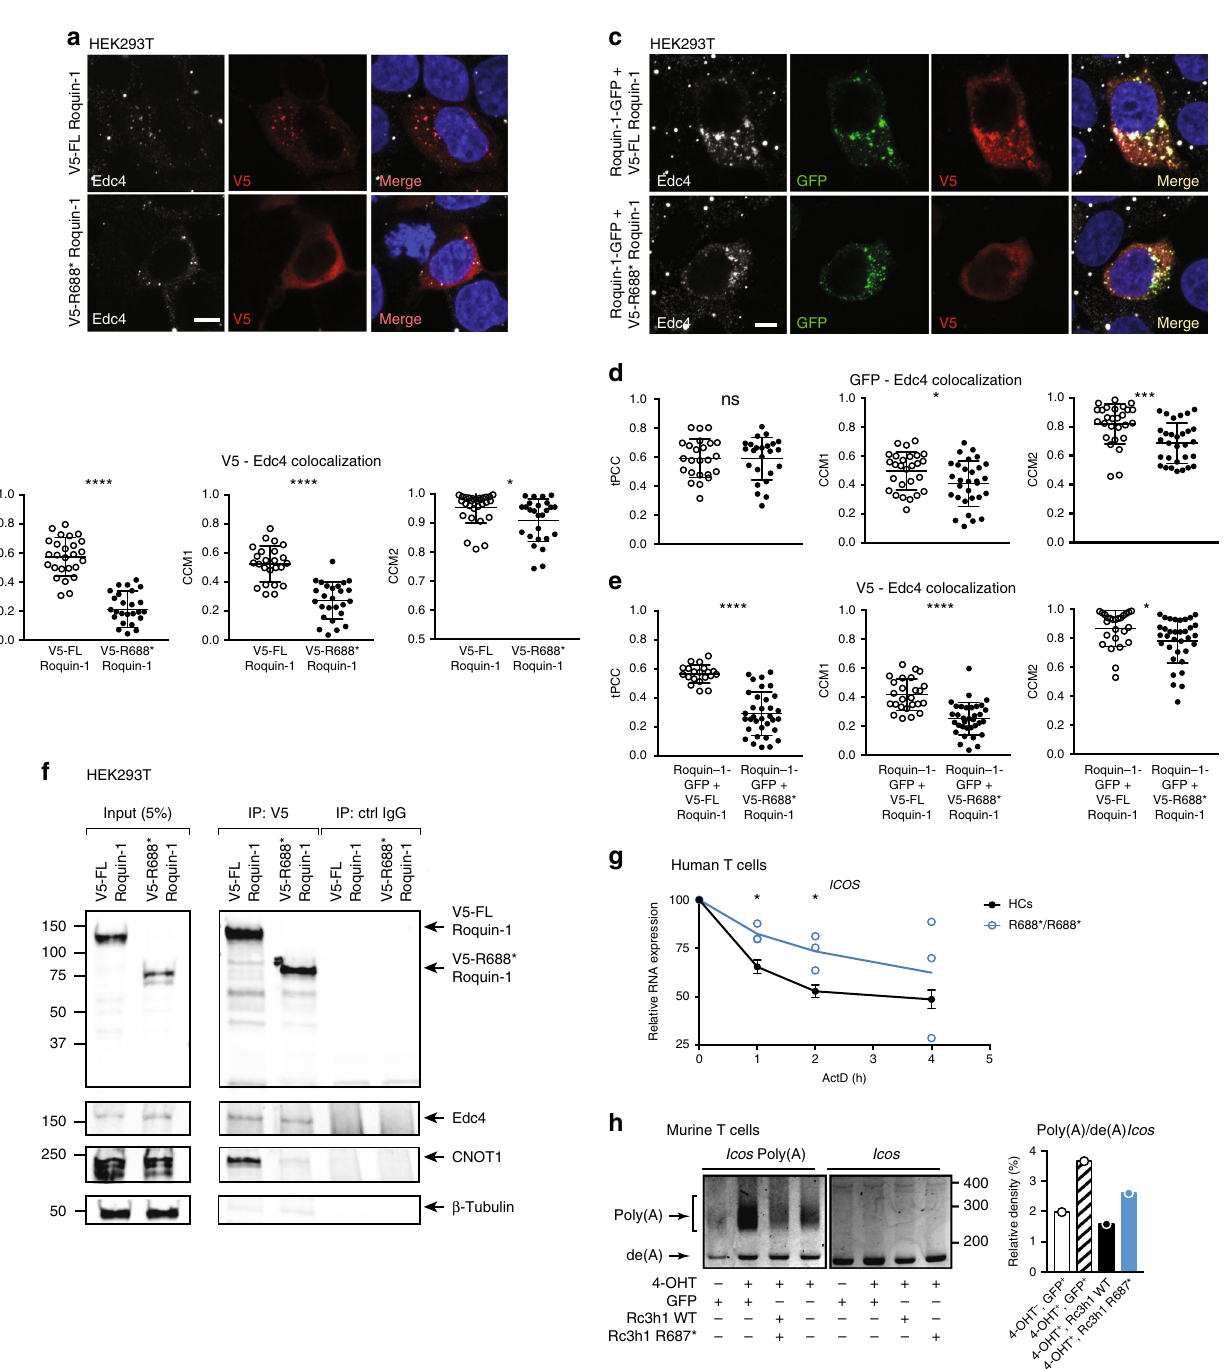
partially crippling Roquin-1 function by interfering with indivi- dual modes of post-transcriptional regulation and resulting in immune de fi ciencies with variable clinical phenotypes.